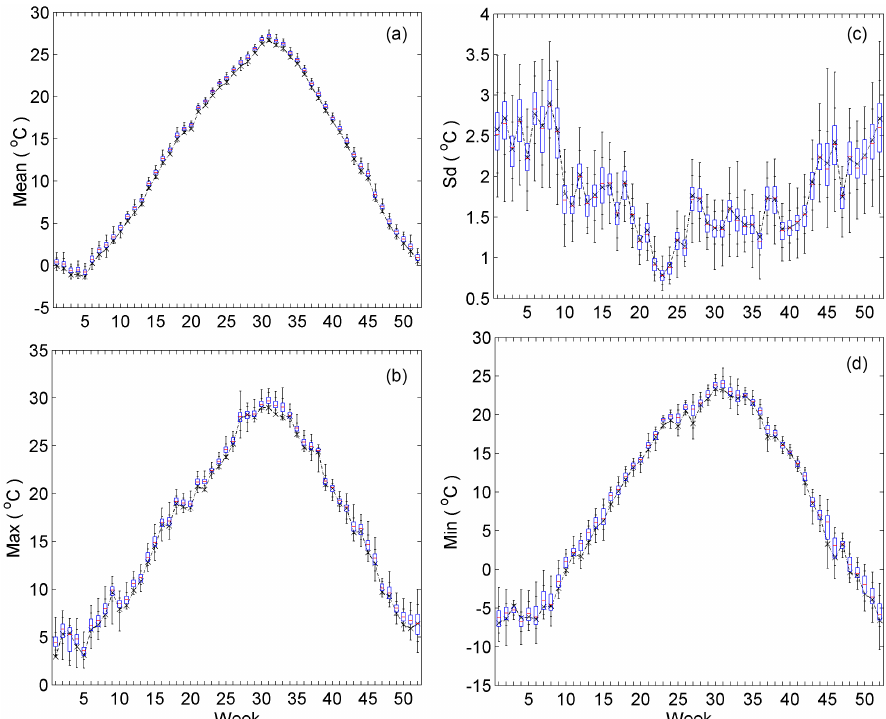
Figure 8. The statistics of the observed (dotted line with cross) and generated (box plot) data for the weekly mean temperature using IBB, with a 0.5 ◦ C temperature increase in Buan, South Korea. Boxes display the interquartile range (IQR), and whiskers extend to the extrema (i.e., maximum and minimum). The horizontal lines inside the boxes depict the median of the data. Note that the mean and maximum of the simulated data are increased significantly compared with the corresponding observed data, while the minimum of the simulated data is slightly increased and the standard deviation of the simulated data agrees with that of the observed data due to the variance inflation, as in Eq.